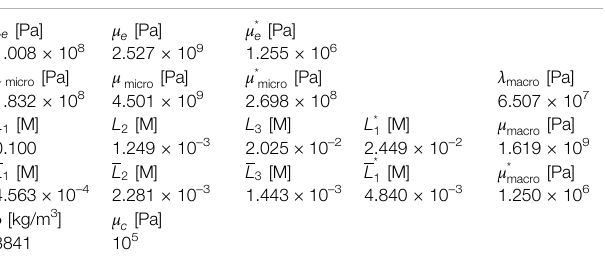
TABLE 1 | Static and dynamic parameters for the metamaterial MM1 . Panel (A) showsthevaluesoftherelaxedmicromorphicstaticanddynamicparametersfor themetamaterial MM1 determinedviathe fi ttingproceduregivenin(d ’ Agostinoetal., 2020; Aivaliotis et al., 2020). The apparent density ρ is computed based on the titanium microstructure of Figure 2A . Panel (B) shows the values of the equivalent Cauchy continuum elastic coef fi cients corresponding to the long- wave limitof MM1 computed withthe procedure explained in(Neffet al., 2020).